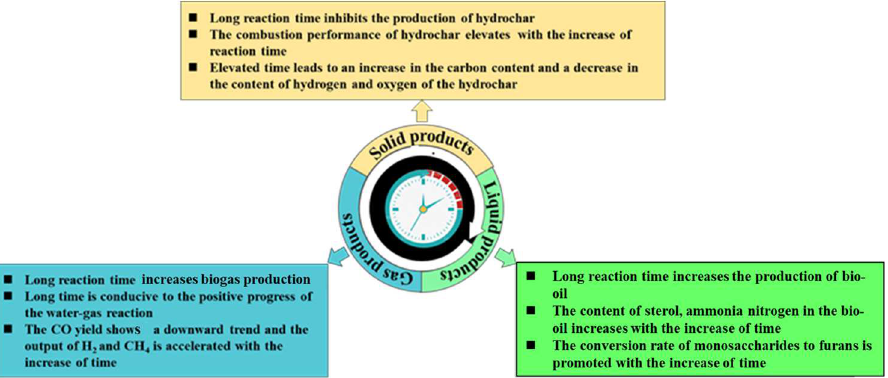
Figure 4. The influence of reaction time on hydrothermal products.